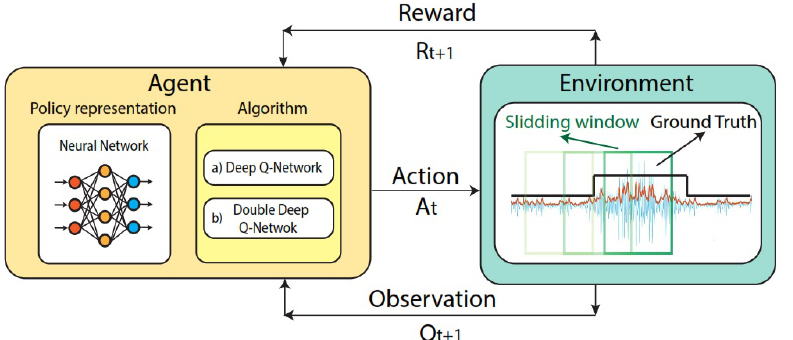
Figure 3. Scheme of the interaction between the Deep Q-Network agent representation and the proposed environment for EMG classification.